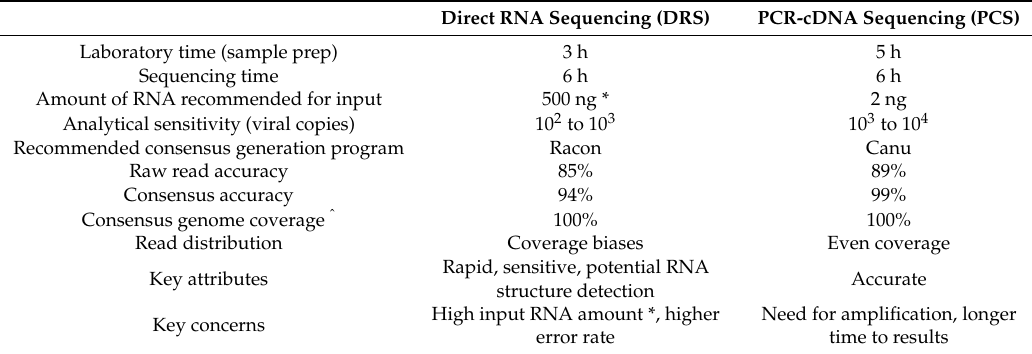
Table 5. Summary of direct RNA sequencing and PCR-cDNA